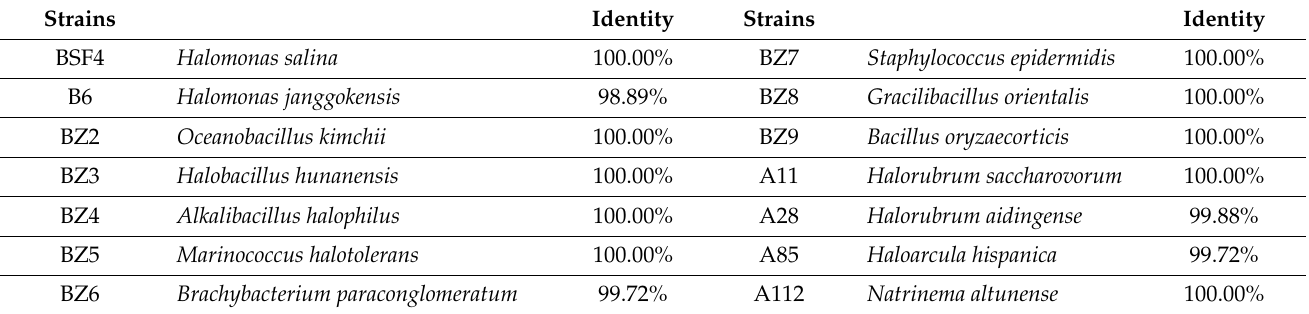
Table 1. Isolation and identification of the endogenous halotolerant microorganisms in silkworm excrement.